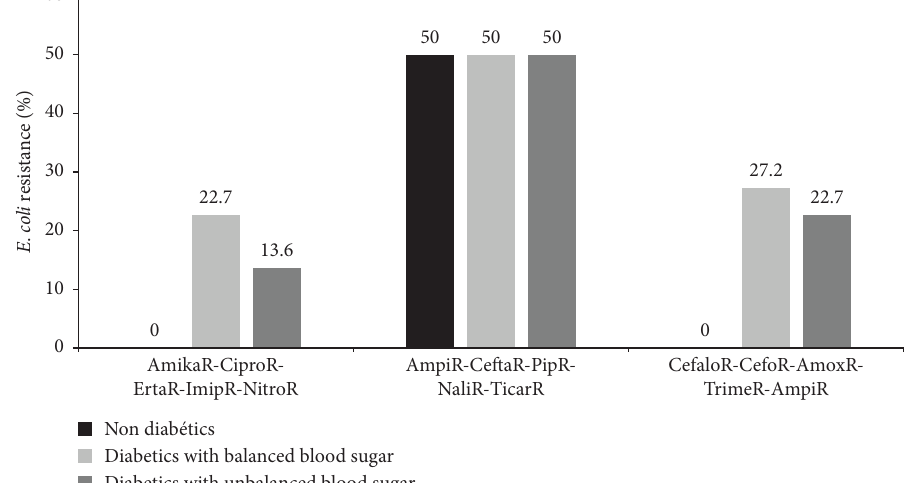
Figure 6: Distribution of E. coli resistance to combination of fve commonly used antibiotics as a function of diabetic status. Amika: amikacin, Amox: amoxicillin, Ampi: ampicillin, Cefalo: cefalotin, Cefo: cefotaxime, Cefta: ceftazidime, Cipro: ciprofoxacin, Erta: erta- penem, Pip: piperacillin, Ticar: ticarcillin, Trime: trimethoprim-sulfamethoxazole, Imip: imipenem, Nitro: nitrofurantoin, and Nali: nalidixic